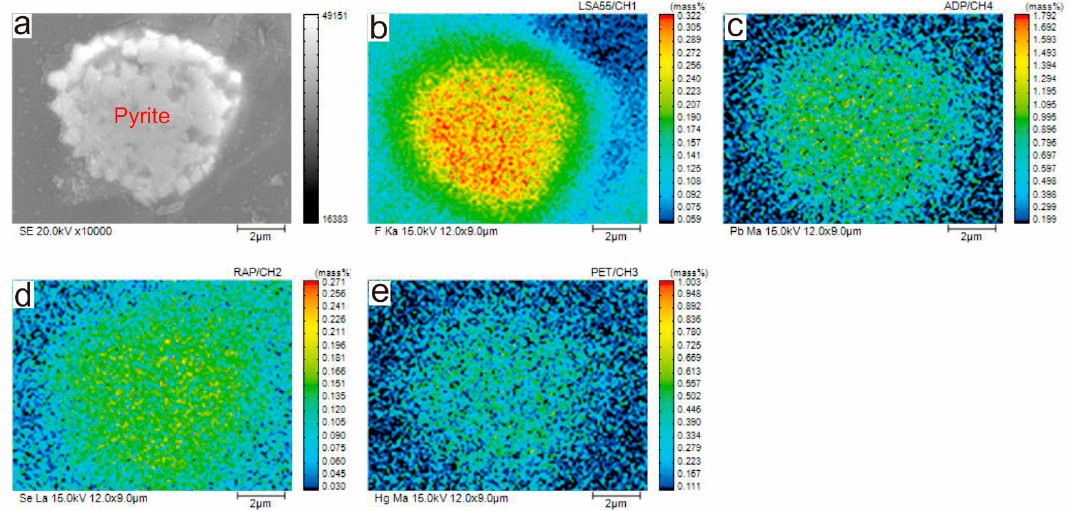
Figure 6. ( a ) Framboidal pyrite from Rongyang; ( b – e ) Energy-dispersive X-ray spectrometer elemental maps of F, Pb, Se, and Hg of ( a ), respectively.